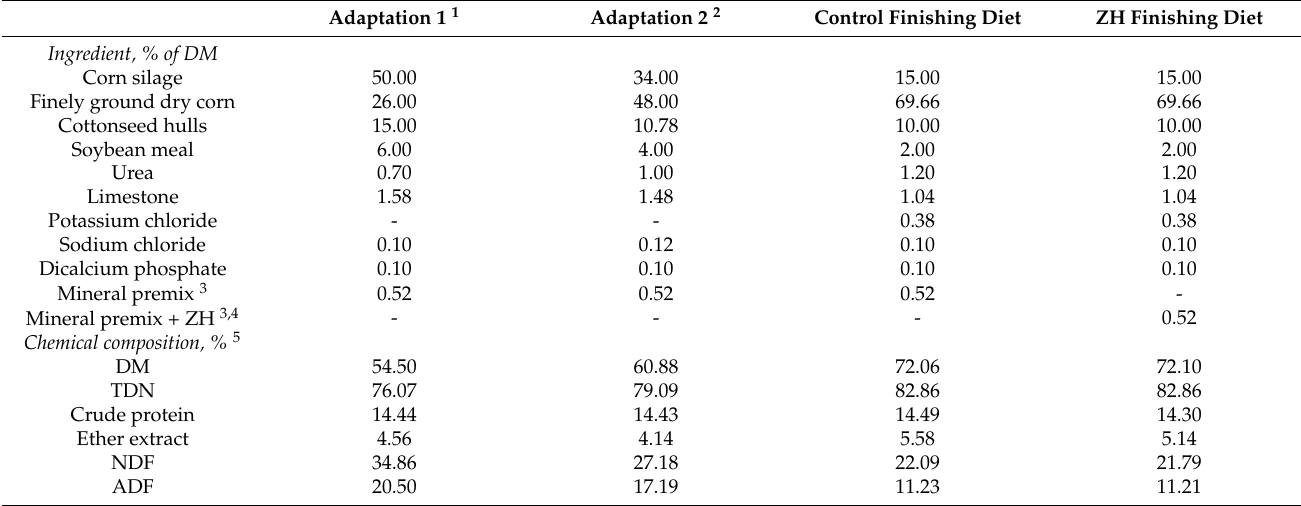
Table 1. Composition of the experimental diets (DM